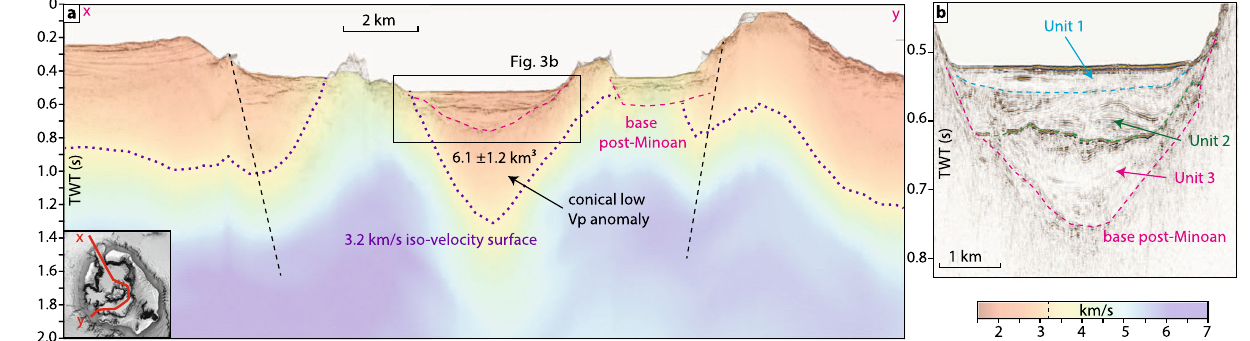
Fig.3|P-wavetomographyandre fl ectionseismics.a Seismicpro fi lecrossingthe Santorinicalderathroughthenorthernbreachintothenorthernbasin,thewestern basin, and the south-western breach. The semi-transparent colours overlaid are from a 3D tomographic V p model 27 . Dashed pink line marks the base of Unit 3, interpreted as the boundary between Minoan and post-Minoan deposits. Dotted